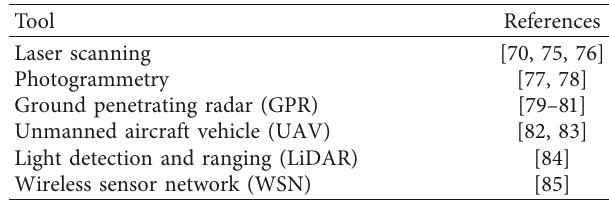
Table 5: Technologies for inspection, automatic damage identifi- cation, and